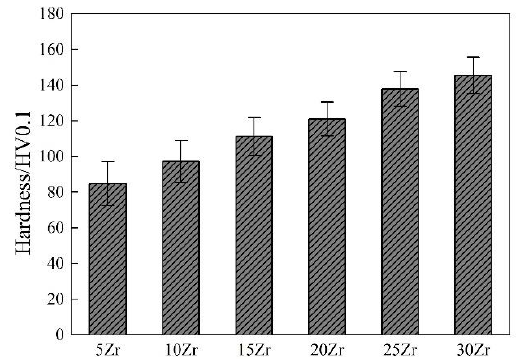
Figure 7. The hardness value of pore wall with different Zr content.